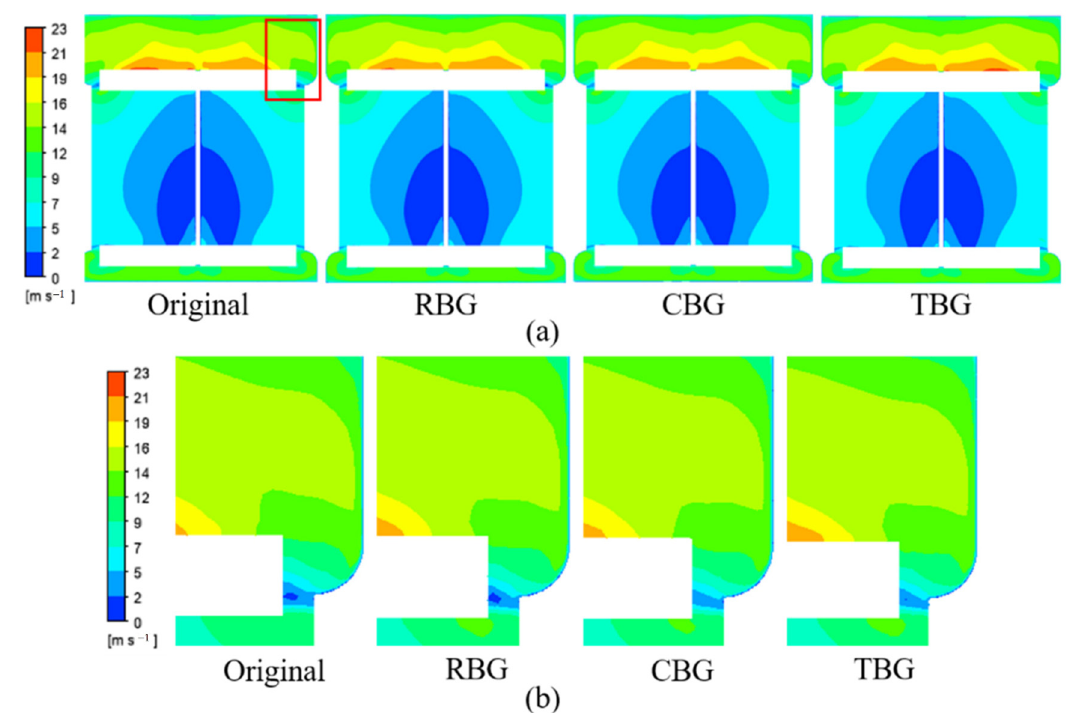
Figure 15. Velocity distribution of section A–A: ( a ) volute and ( b ) impeller tip.